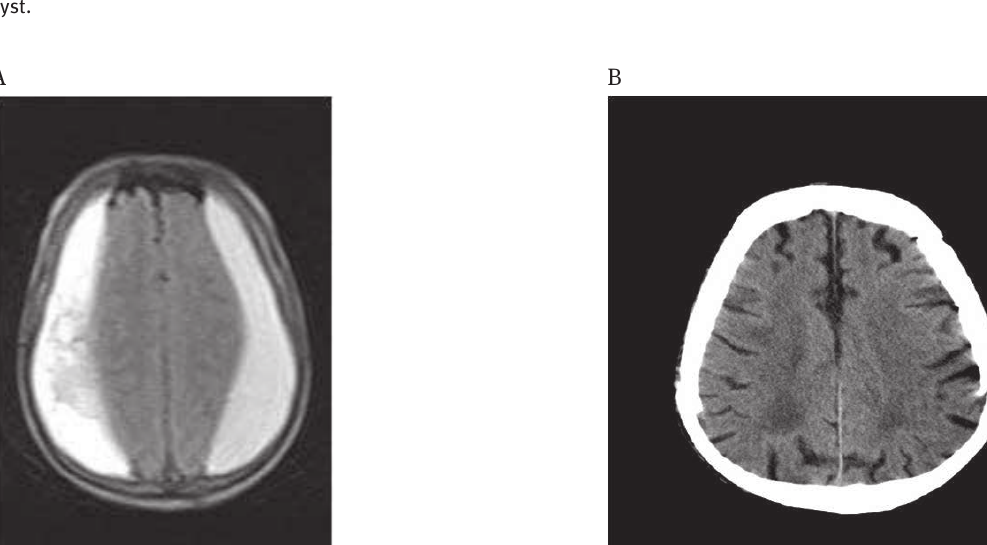
Figure 4: Axial T2-weighted MRI; Right frontoparietal inhomogenous residual chronic subdural hematoma,